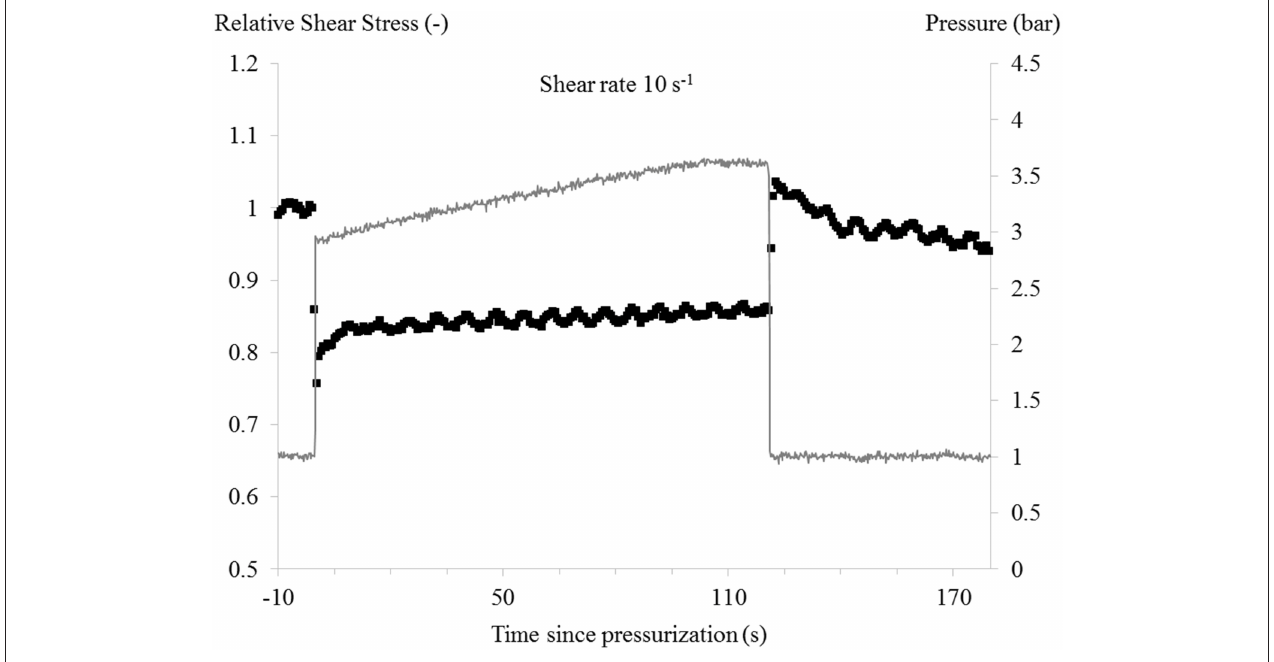
FIGURE 13 | Rate of air dissolution and reappearance at a shear rate of 10 s − 1